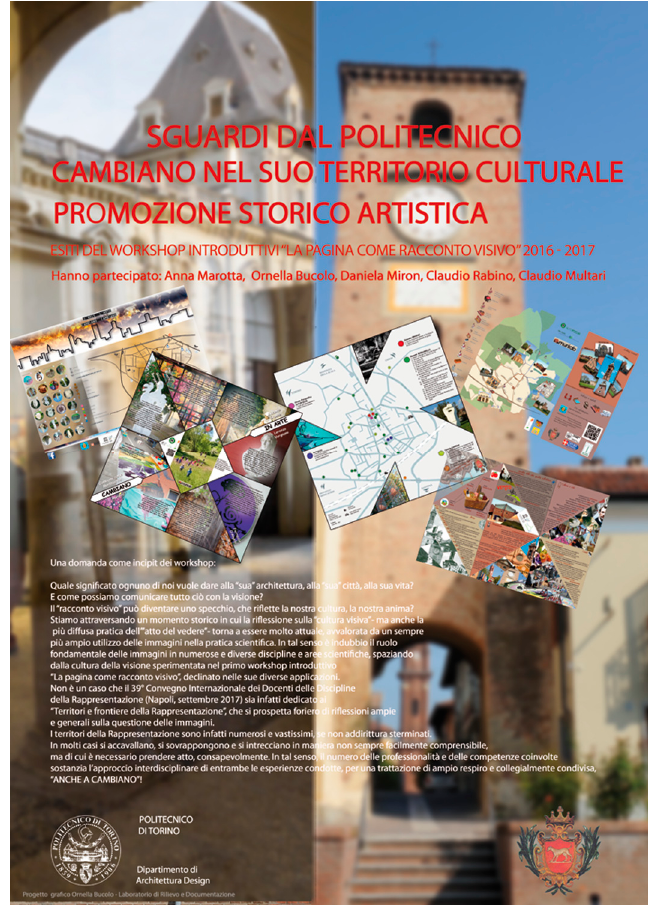
Figure 5. Presentation poster of the workshop’s outcomes for Cambiano. In the background there are two architectural portals representing Politecnico and the historical center of the city. On the foreground there are details of the promotional panels and promotional brochures of